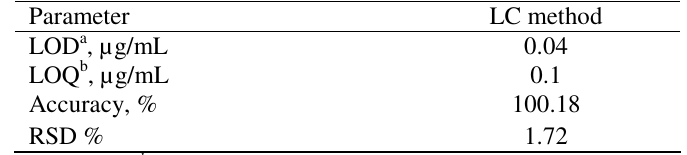
Table 3. Summary of validation parameters for donepezil hydrochloride by the proposed LC method .